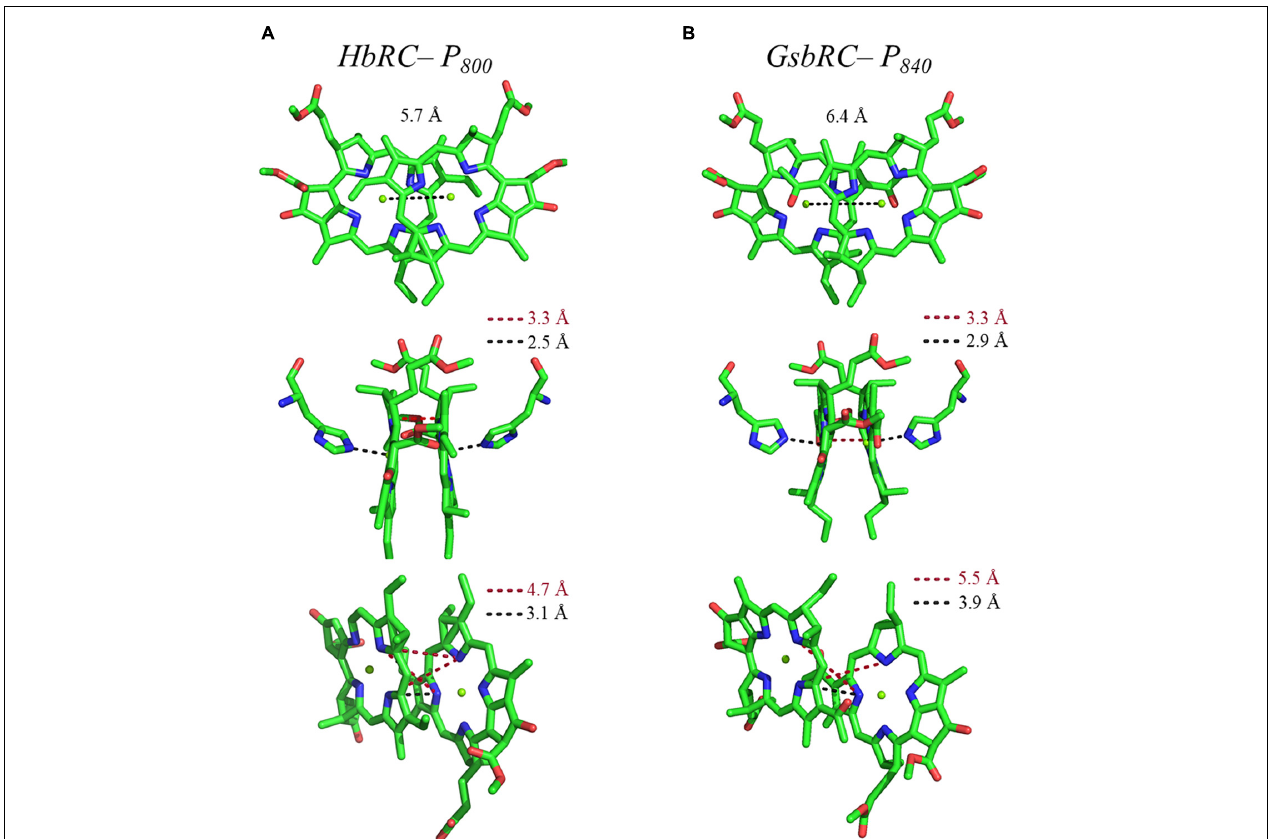
FIGURE 9 | Analysis of inter-cofactor distances and relative orientation of primary donors from the homodimeric RCs: (A) P 800 from the HbRC, and (B) P 840 from the GsbRC.